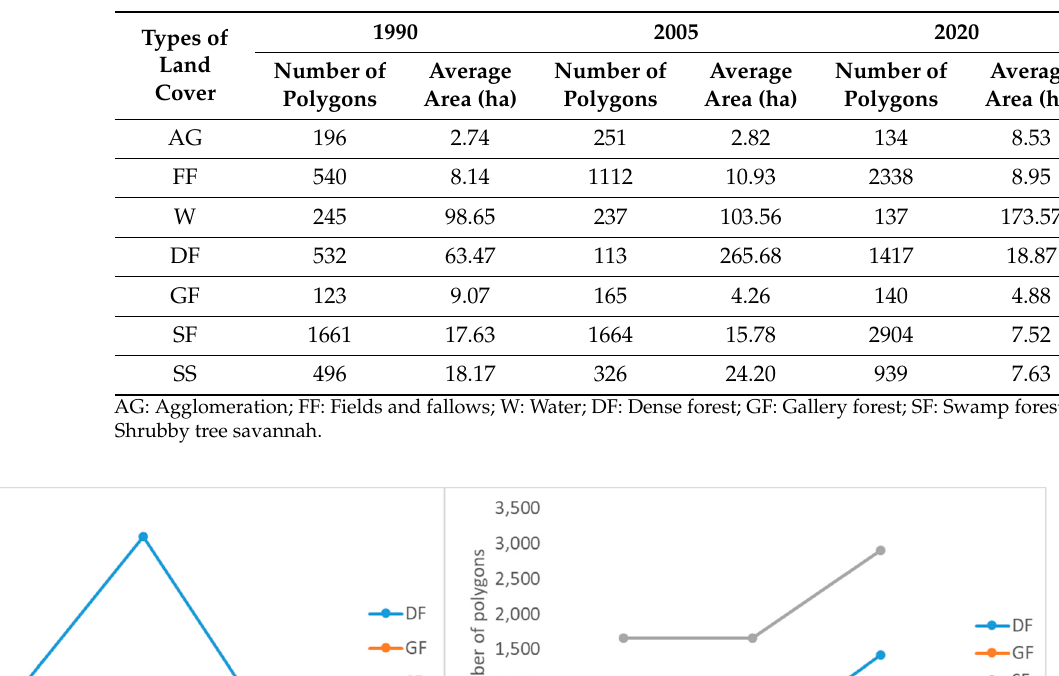
Table 5. Evolution of the average area and the number of polygons according to the observation periods.